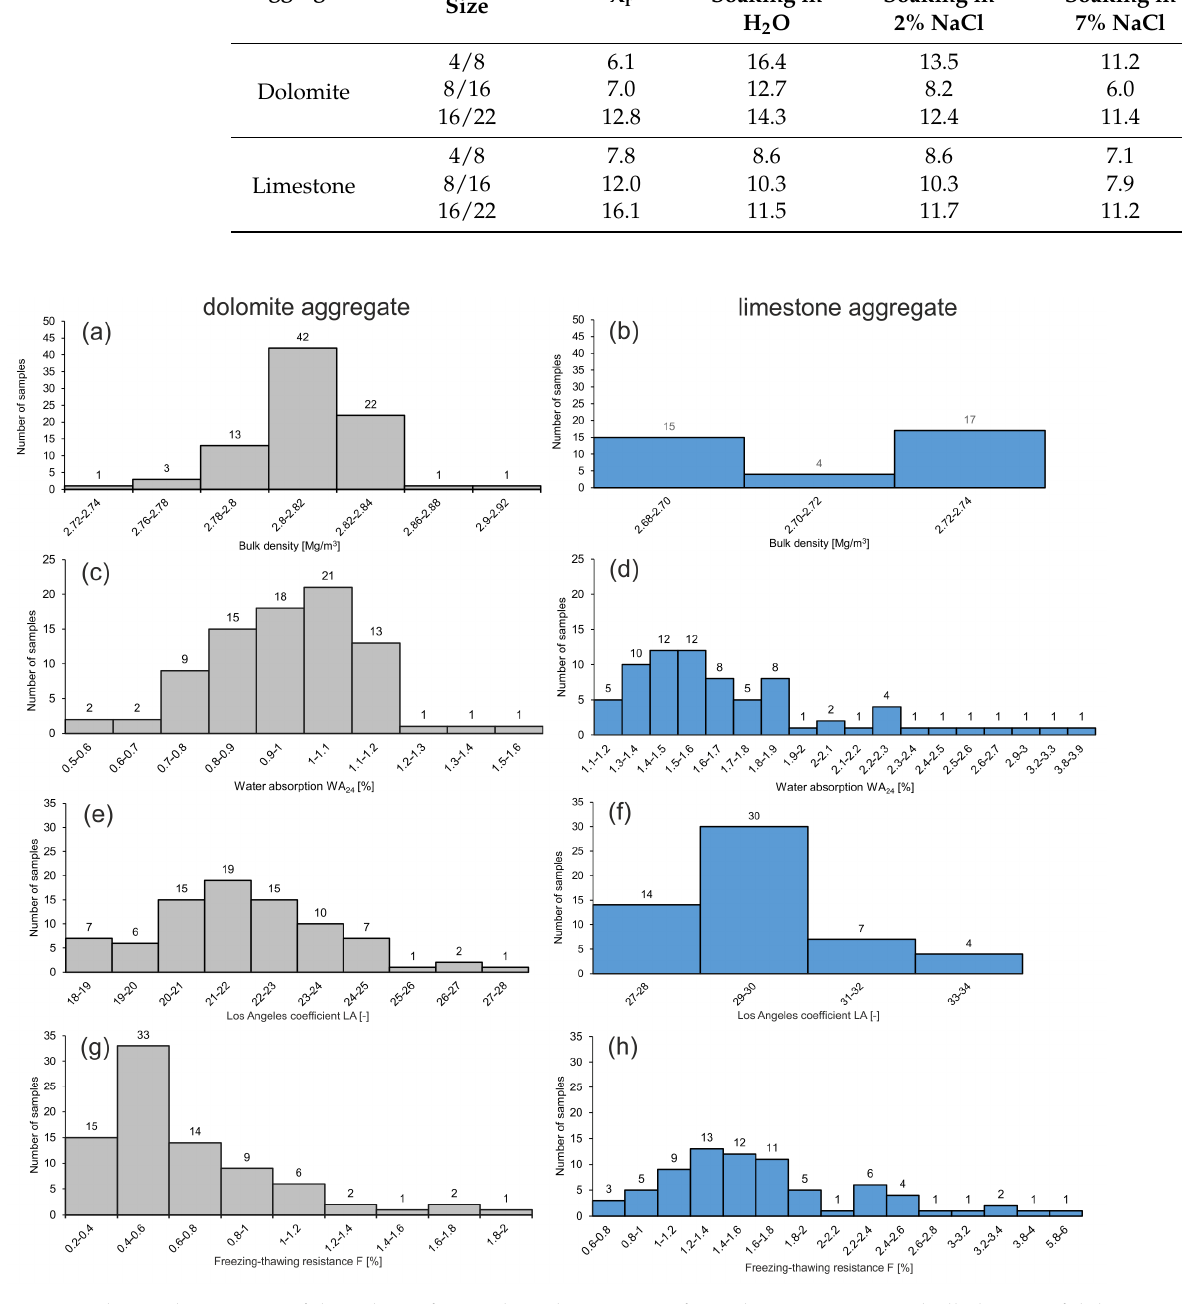
Figure 5. Distribution histograms of the values of geotechnical parameters for carbonate aggregate: bulk density of dolomite ( a ) and limestone ( b ) aggregate; water absorption WA24 of dolomite ( c ) and limestone ( d ) aggregate; Los Angeles coefficient LA–resistance to fragmentation of dolomite ( e ) and limestone ( f ) aggregate; ( d ) freezing–thawing resistance F of dolomite ( g ) and limestone ( h ) aggregate.